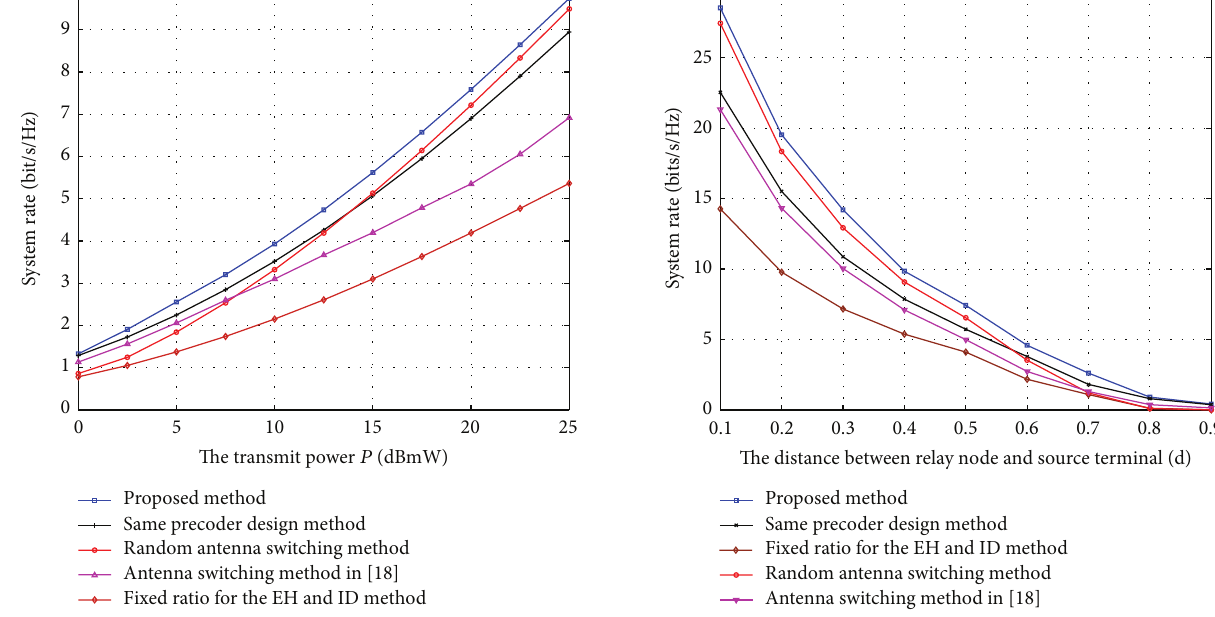
Figure 2: Achievable sum rate of the SWIPT relay network for different transmission strategy.